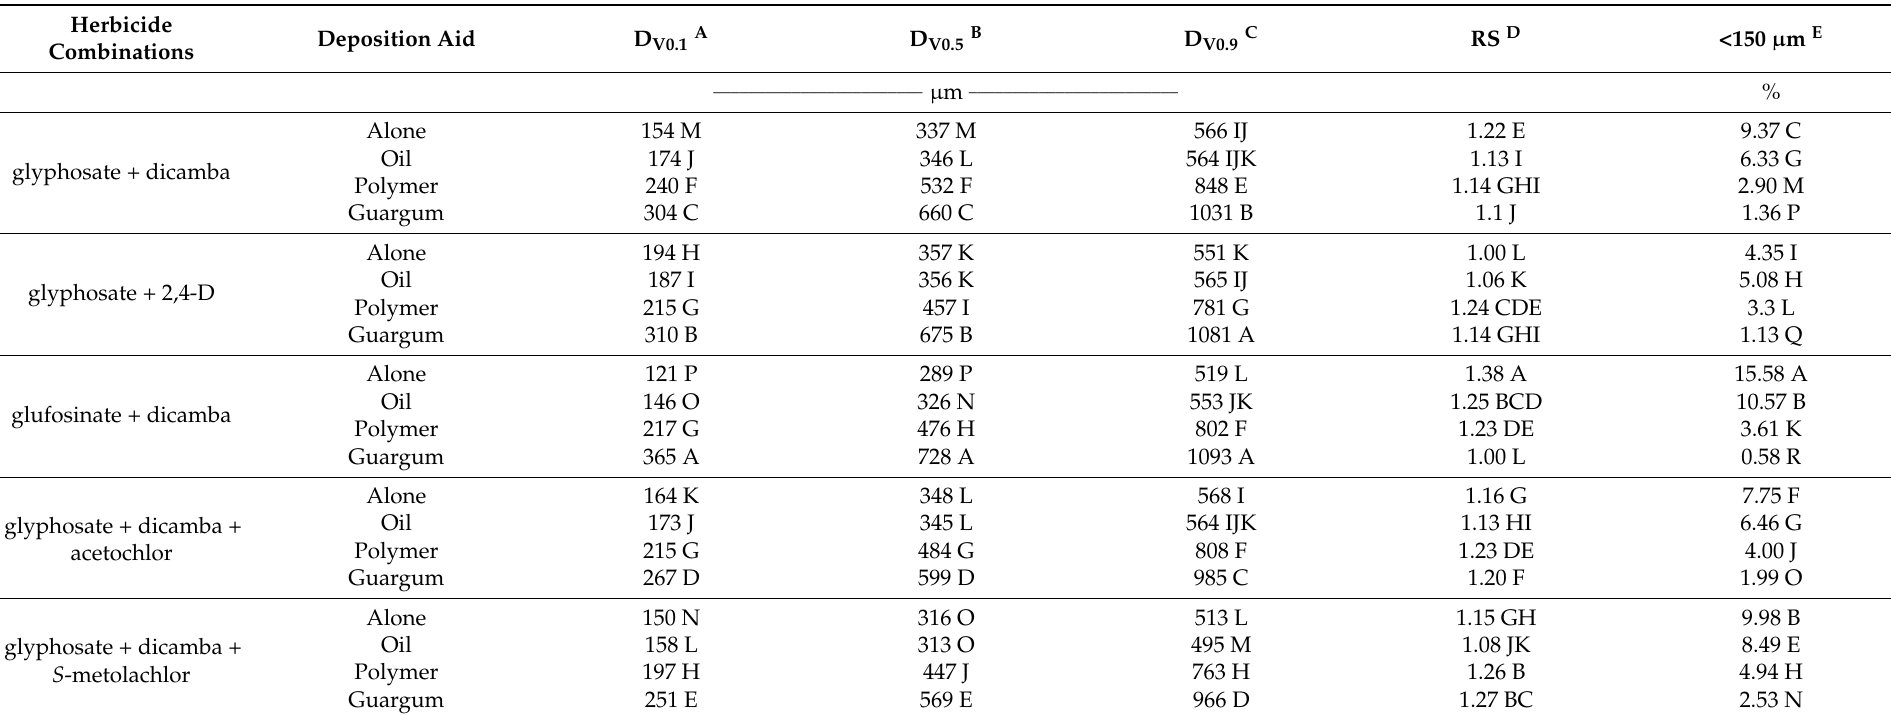
Table 6. Effect of cotton herbicide combinations and deposition aids on spray D V0.5 , D V0.1 , D V0.9 , relative span, and <150 µ m. Means within a column followed by the same letter are not significantly different ( α ≤